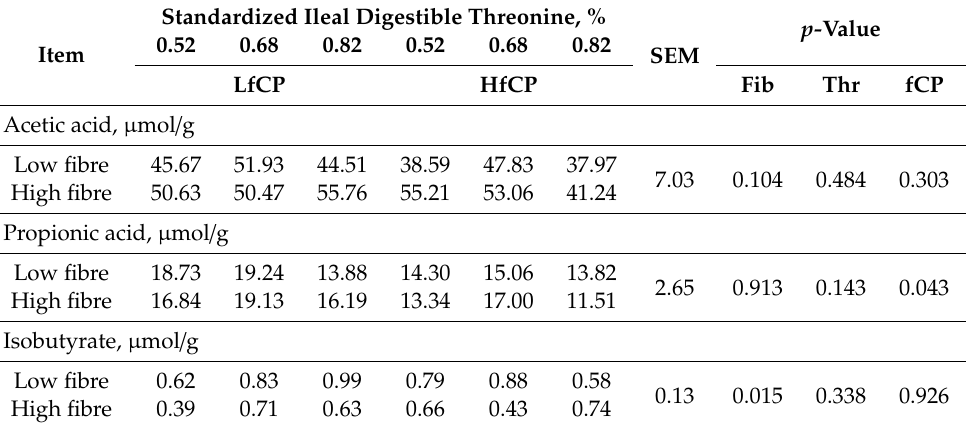
Table 4. Short-chain ( SCFA ), branched-chain ( BCFA ) fatty acid and ammonia concentration in the colonic digesta 1